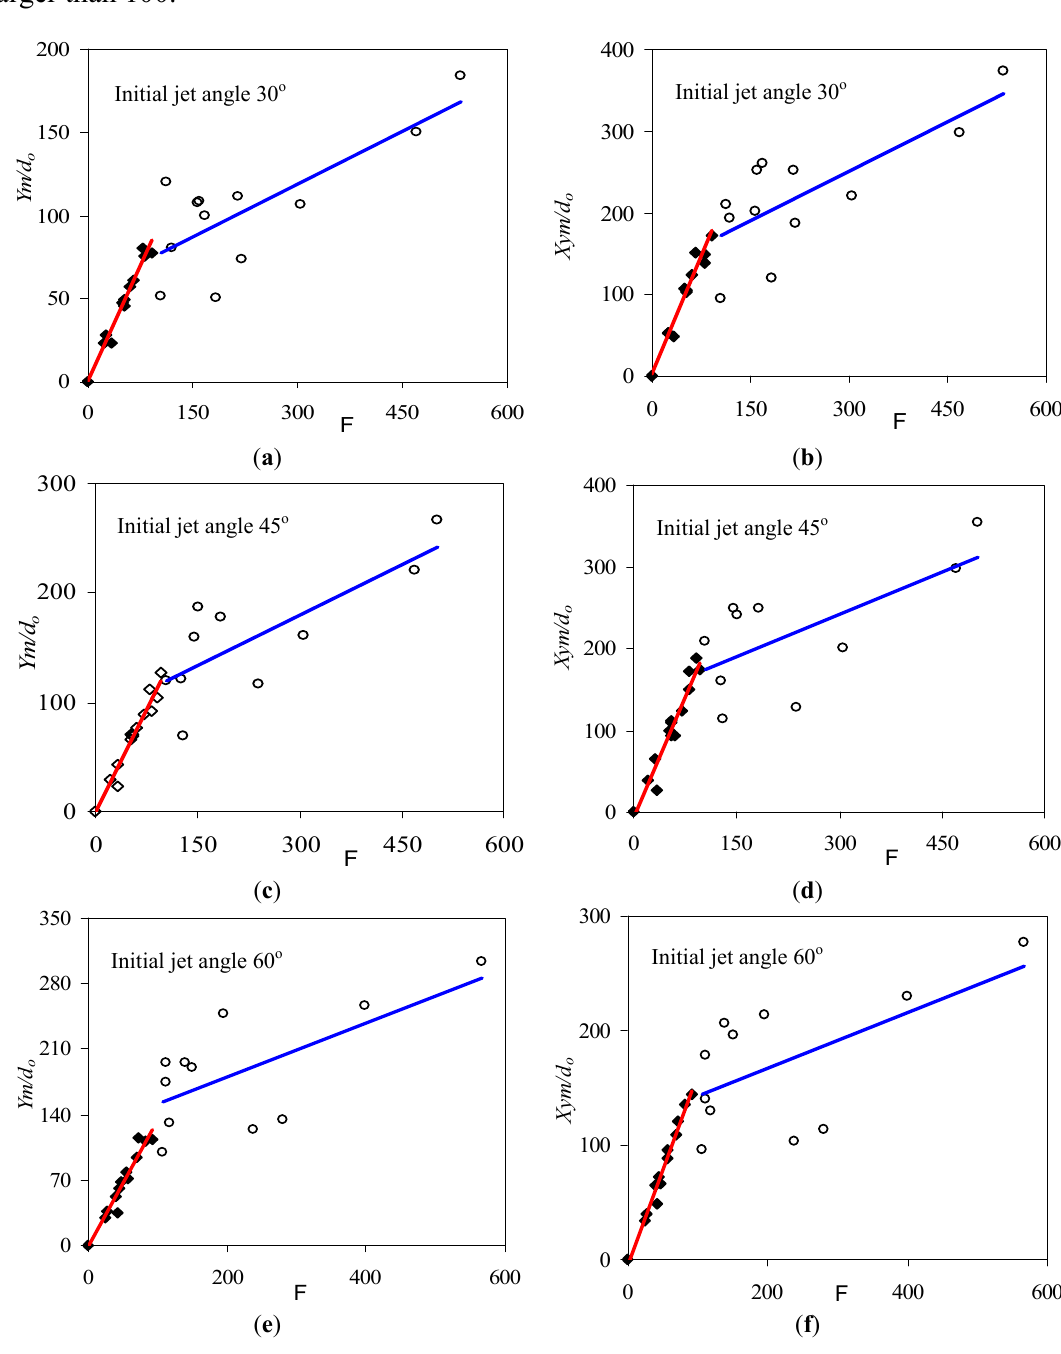
and X as a function of F for different /d /d m o ym o